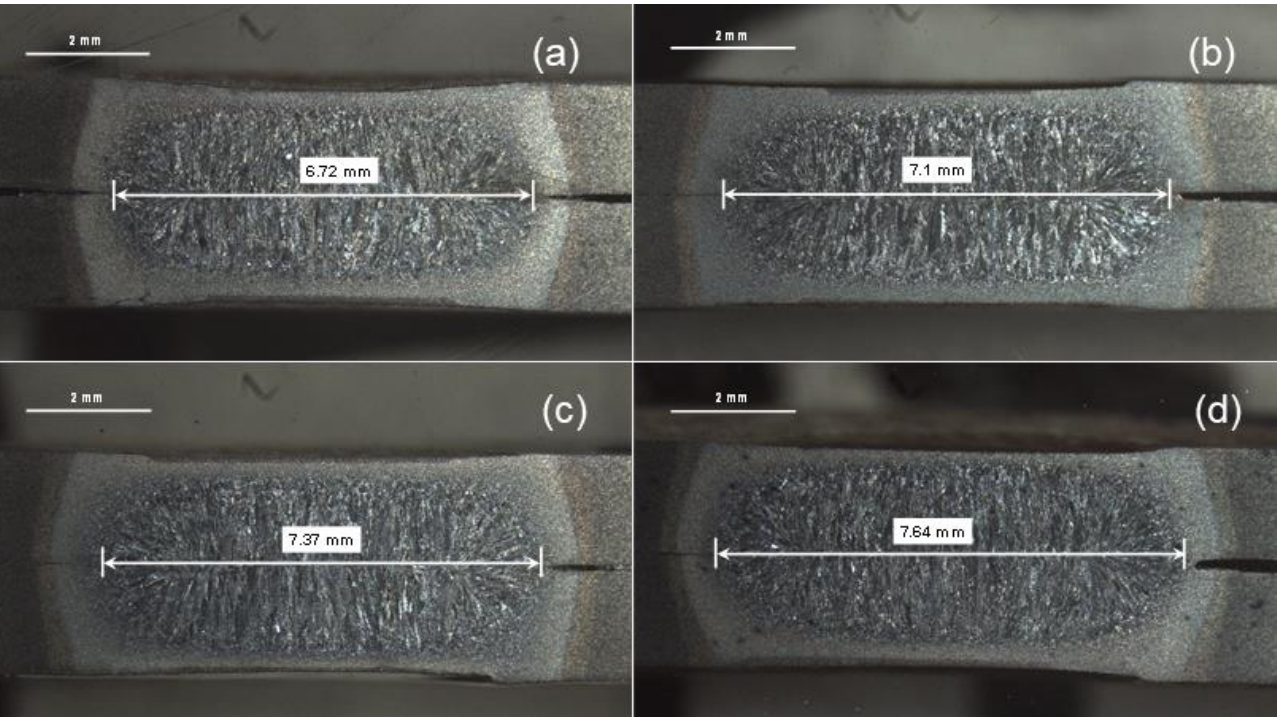
Figure 10. Macrostructure illustrating FZ size. ( a ) sample 1, ( b ) sample 8, ( c ) sample 12 and ( d ) sample 16.